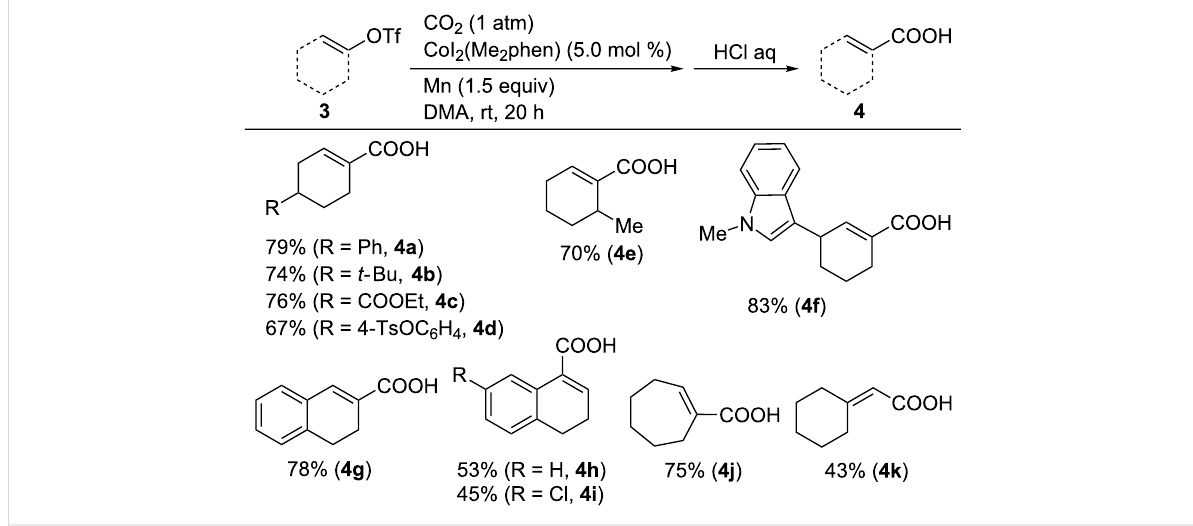
Scheme 5: Co-catalyzed carboxylation of vinyl triflates 3 .